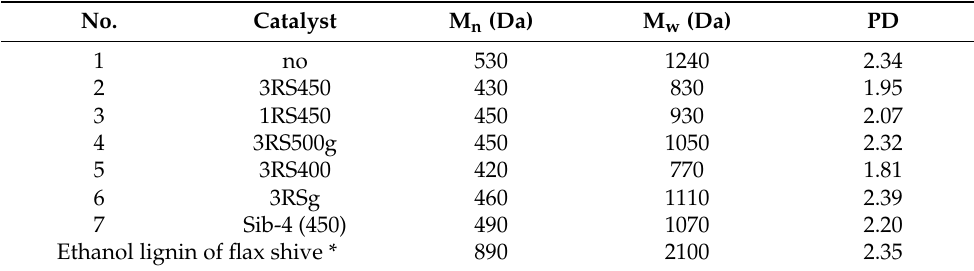
Table 9. Data on the molecular weight distribution of the liquid products of reductive catalytic fractionation of flax shive in subcritical ethanol at 225 ◦